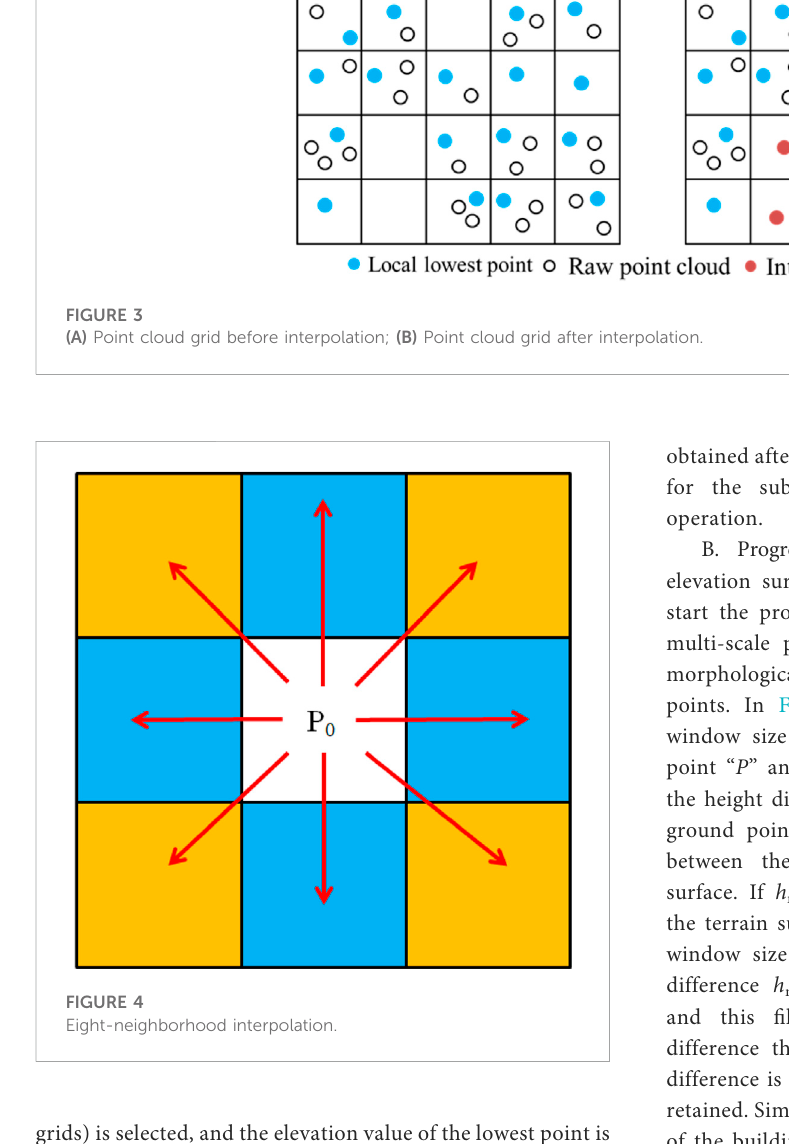
grids) is selected, and the elevation value of the lowest point is used as the grid value. Since the grid data may have null values, it is necessary to interpolate the grid in eight neighborhoods (Figure 4, with point “ P 0 ” as the starting point, and interpolate to the surrounding eight grids). The minimum value of the elevation in the null grid is taken as the average of the elevation sum of the neighboring grids. If the interpolation fails, the elevation value of the grid is assigned to “ 0 ” , such as the red points in the grid in Figure 3B. The interpolation process avoids the missing point clouds in places with large slopes due to the lack of laser scanning, which affects the correct selection of subsequent seed points. The minimum elevation surface is